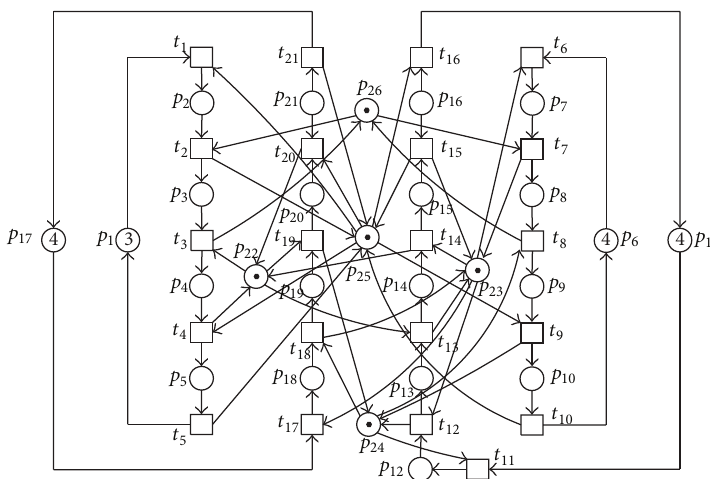
Figure 3: An S 3 PR